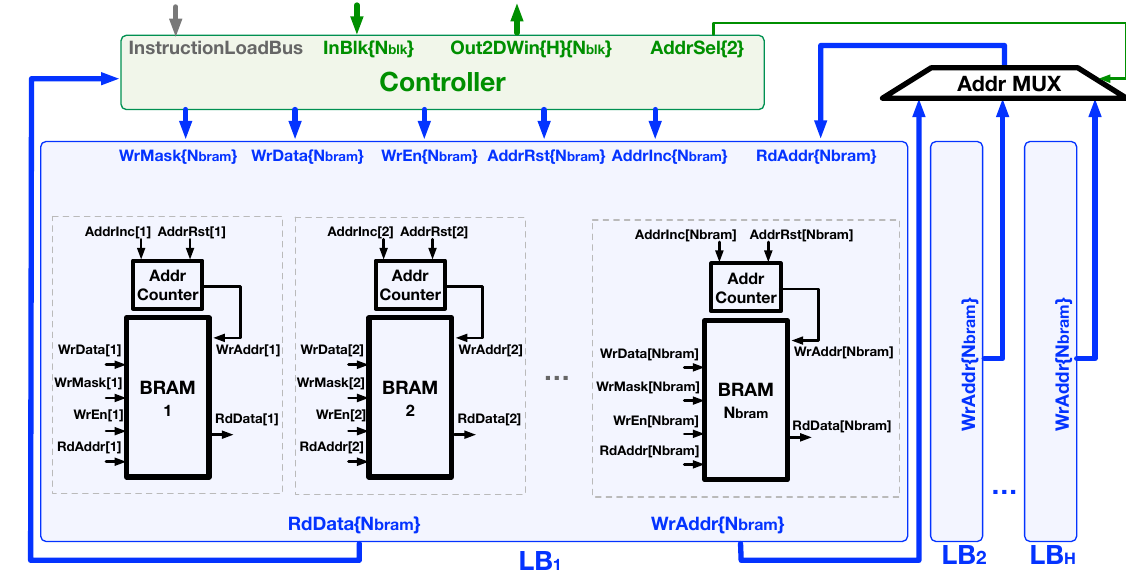
Figure 9. The D-SWIM buffer is composed of LBs and Controller . Each BRAM in the LB is equipped with an Address Counter to manage the write address. It performs address incrementation or reset according to the signal on the controller bus. The Addr MUX allows the write addresses to be broadcasted during a block write operation of a specific LB as the read addresses of the other LBs for block